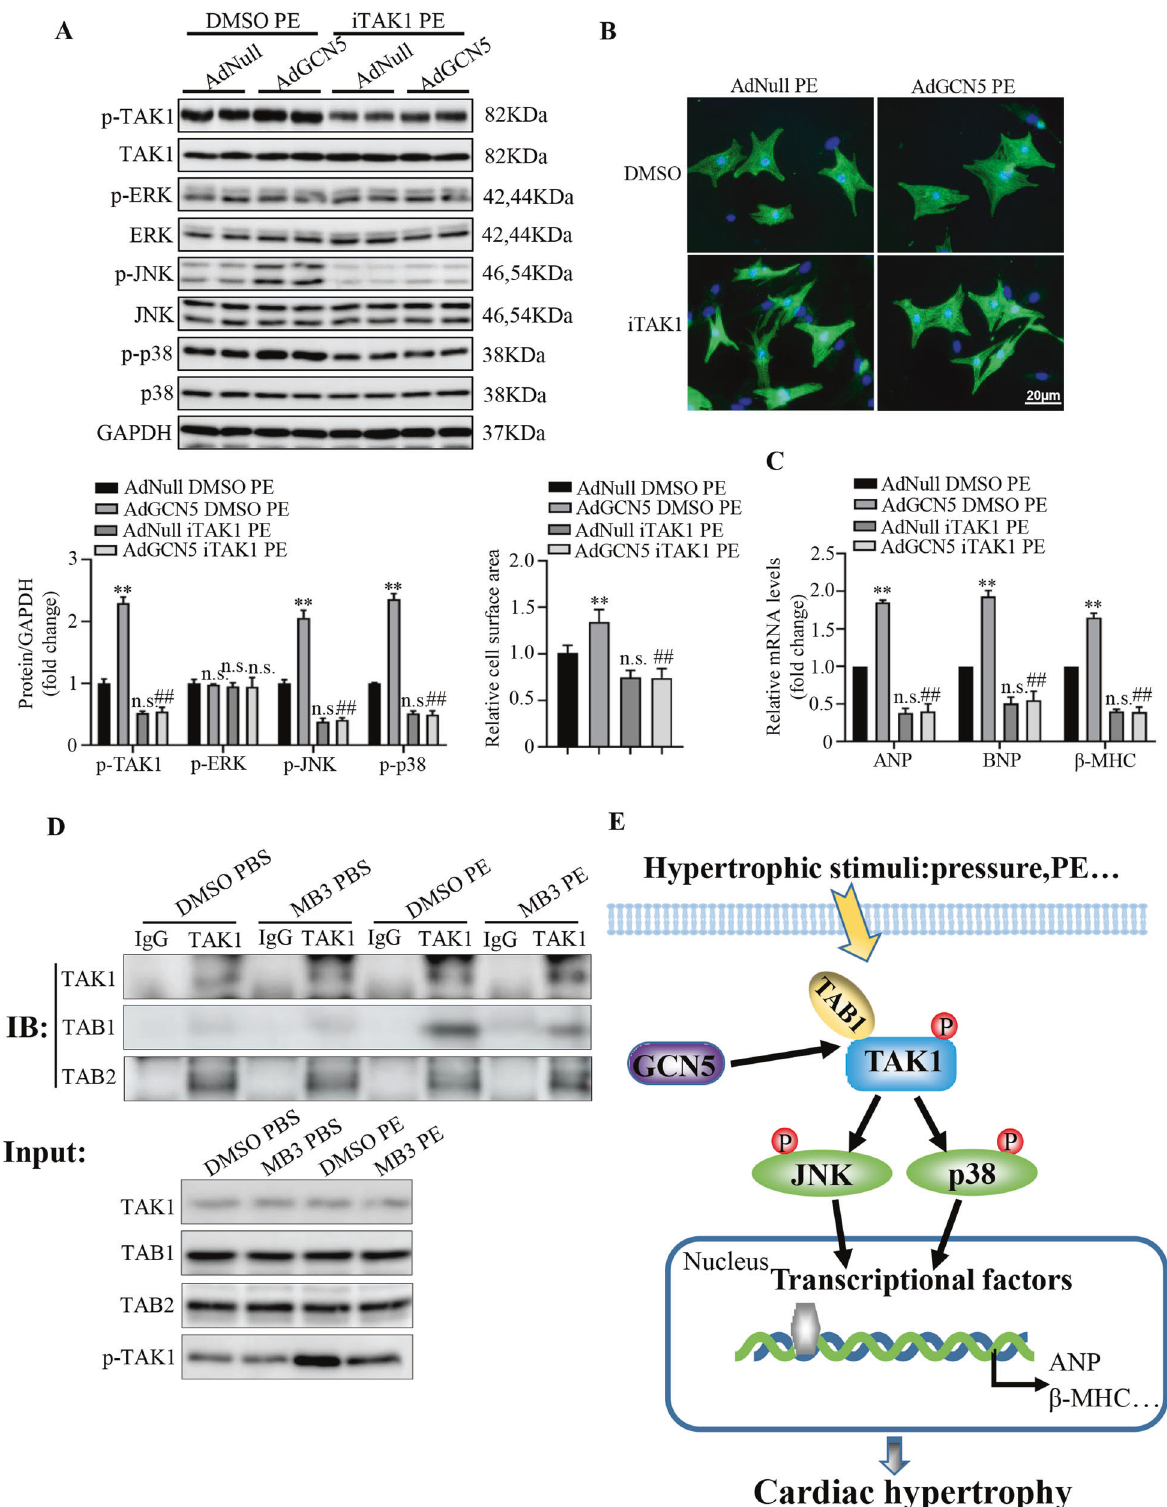
Fig. 7 Inhibition GCN5 activity reduces binding of TAB1 and TAK1 and blocks TAK1 activation. A Western blots showing the activity of TAK1-JNK/p38 signaling pathway components in NRCMs infected with AdNull or AdGCN5 for 24 h, under treatment with PE and DMSO or iTAK1. B Effects of iTAK1 on cardiomyocyte surface areas in NRCMs infected with AdNull or AdGCN5 under PE treatment. C Effects of iTAK1 on hypertrophic marker genes in NRCMs infected with AdNull or AdGCN5 for 24 h under PE treatment (n.s., ∗∗ P < 0.01 vs AdNull DMSO PE; n.s., ## P < 0.01 vs AdGCN5 DMSO PE; n.s. vs AdGCN5 iTAK1 PE). D Effects of GCN5 inhibitor MB3 on binding of TAK1 with TAB1 and TAB2 in NRCMs under PE treatment. E Schematic diagram showing how GCN5 regulates cardiac hypertrophy. Data are shown as the mean ± SD from three independent